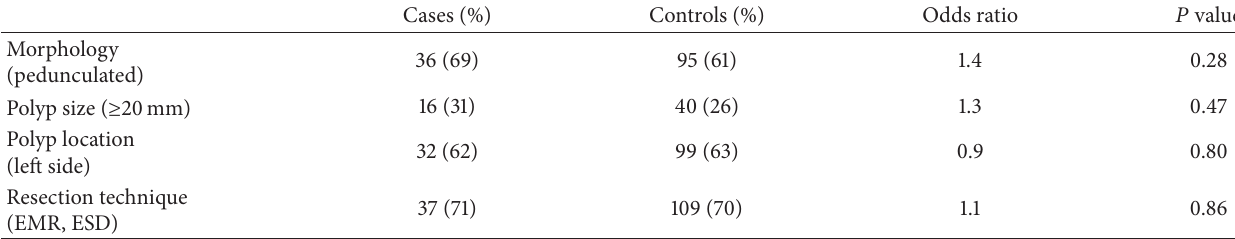
Table 3: Univariate analysis of tumor-factors for delayed bleeding.